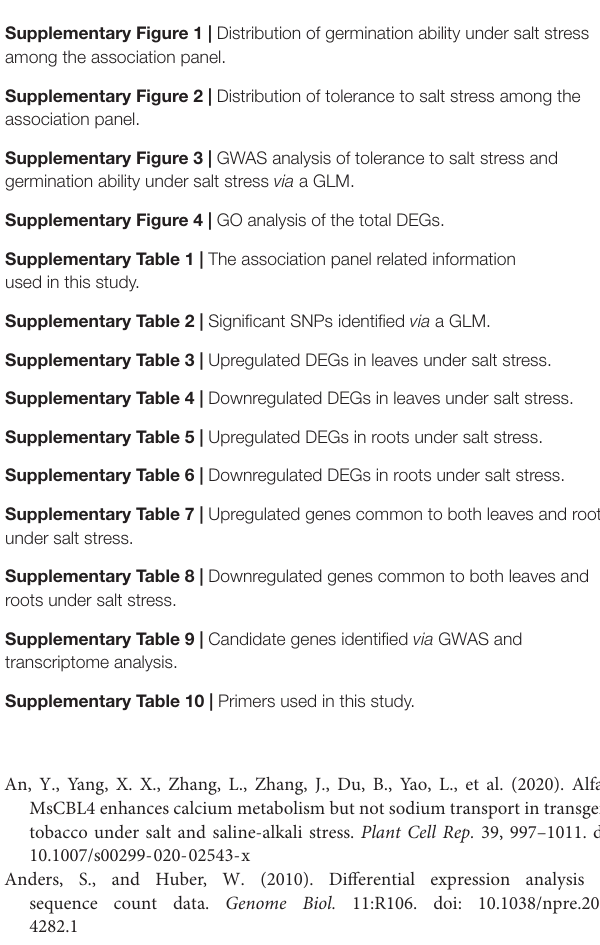
Supplementary Figure 1 | Distribution of germination ability under salt stress among the association panel. Supplementary Figure 2 | Distribution of tolerance to salt stress among the association panel. Supplementary Figure 3 | GWAS analysis of tolerance to salt stress and germination ability under salt stress via a GLM. Supplementary Figure 4 | GO analysis of the total DEGs. Supplementary Table 1 | The association panel related information used in this study. Supplementary Table 2 | Significant SNPs identified via a GLM. Supplementary Table 3 | Upregulated DEGs in leaves under salt stress. Supplementary Table 4 | Downregulated DEGs in leaves under salt stress. Supplementary Table 5 | Upregulated DEGs in roots under salt stress. Supplementary Table 6 | Downregulated DEGs in roots under salt stress. Supplementary Table 7 | Upregulated genes common to both leaves and roots under salt stress. Supplementary Table 8 | Downregulated genes common to both leaves and roots under salt stress. Supplementary Table 9 | Candidate genes identified via GWAS and transcriptome analysis. Supplementary Table 10 | Primers used in this